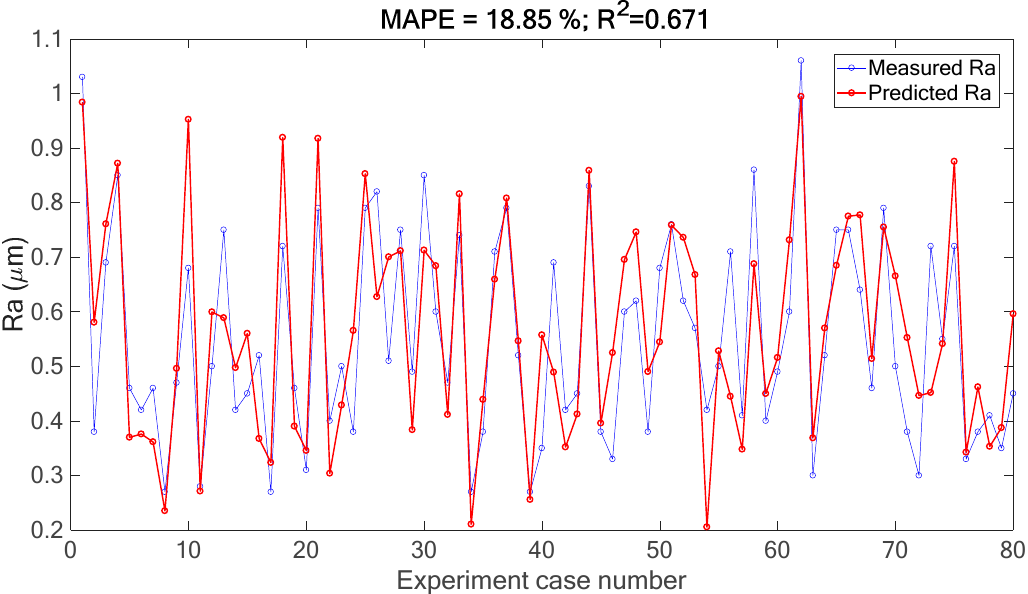
Figure 7. Prediction results of Ra values through Elman neural network by using signal features.